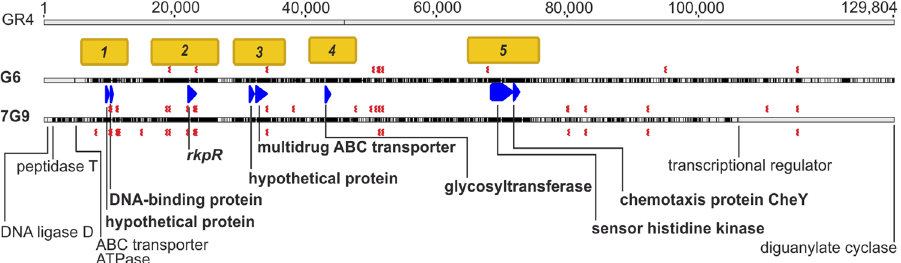
Figure 3. The pSymB core genes of the GID. Alignment of concatenated genes encompassing the GID conserved in all GR4-type isolates (Supplementary Data 3). Only the 7G9, G6 and reference GR4 strain sequences are shown, for the sake of clarity. The identified regions (1 to 5) displaying higher levels of nucleotide sequence diversity (orange) within the GID are shown, together with the genes displaying the highest levels of diversity within each region (blue): in Region 1 (5,750–13,028), hypothetical protein (WP_015243219.1) and DNA-binding protein (WP_003533107.1); in Region 2 (16,528–26,785), capsule polysaccharide export protein R kpR (WP_015243241.1); in Region 3 (29,035–37,036), hypothetical protein (WP_010975434.1) and multidrug ABC transporter ATPase/permease (WP_015243259.1); in Region 4 (40,537–47,788), a glycosyltransferase involved in cell wall biogenesis (WP_015243266.1); and in Region 5 (64,849–75,854), sensor histidine kinase (WP_015243309.1) and chemotaxis protein CheY (WP_015243310.1). The red symbol below each sequence indicates the position of the flexible genome removed for alignment purposes. Discordances with respect to the consensus sequence are shown in black.